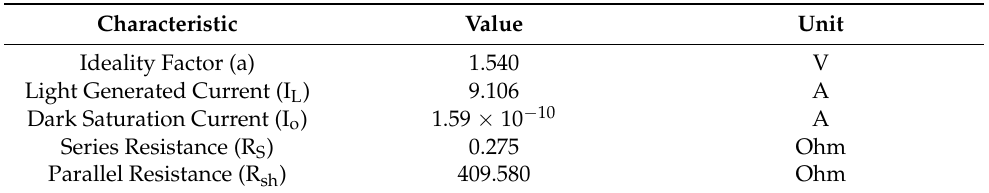
Table 3. Characteristics of the photovoltaic module Astronergy Solarmodule ASM6610P 265, pro- vided by US Sandia National Laboratories and US National Renewable Energy Laboratory (NREL). Characteristic Value Unit Ideality Factor (a) 1.540 V Light Generated Current (I L )